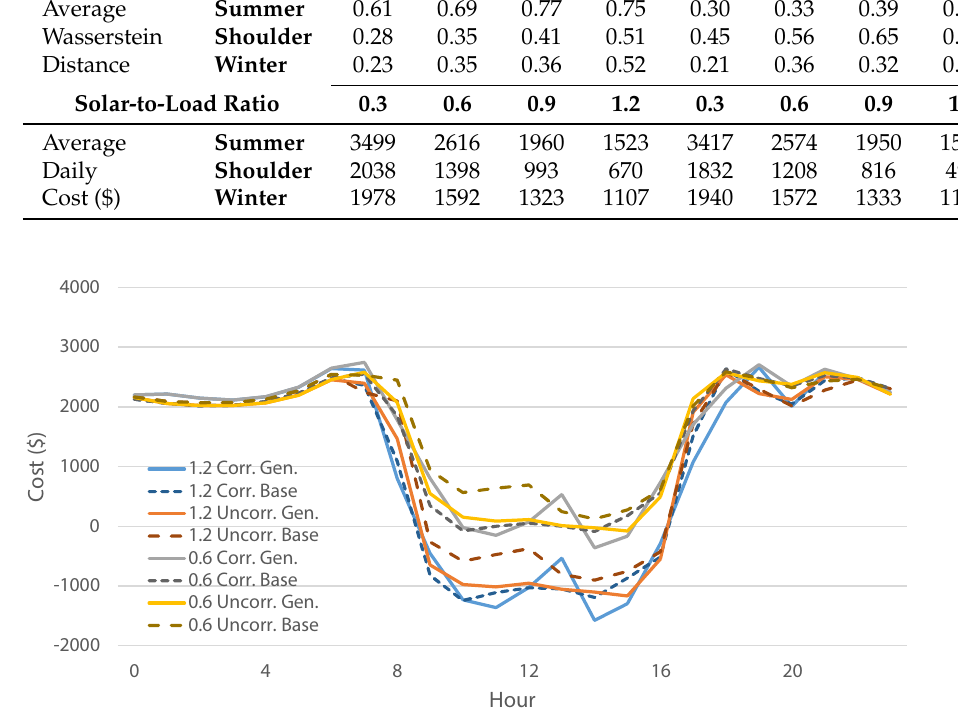
Figure 13. Winter normal hourly OPF costs (ratio = 0.6, 1.2).